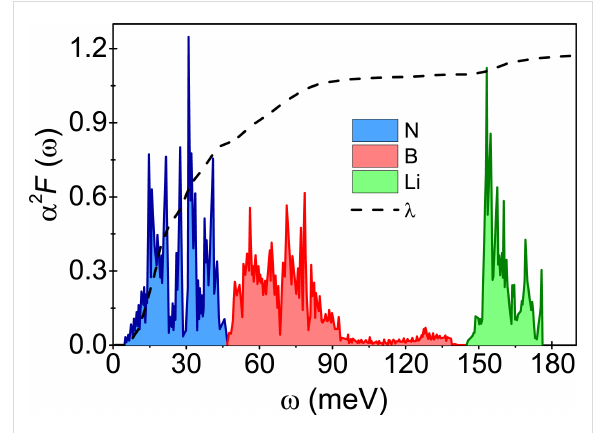
Figure 5: Eliashberg function α 2 F ( ω ) and electron–phonon coupling function for Li-hBN. The results were ob- tained in [41]. The figure also indicates the contributions from nitrogen, boron and lithium, λ N = 0.82, λ B = 0.25, and λ Li = 0.1, where λ N + λ B + λ Li =